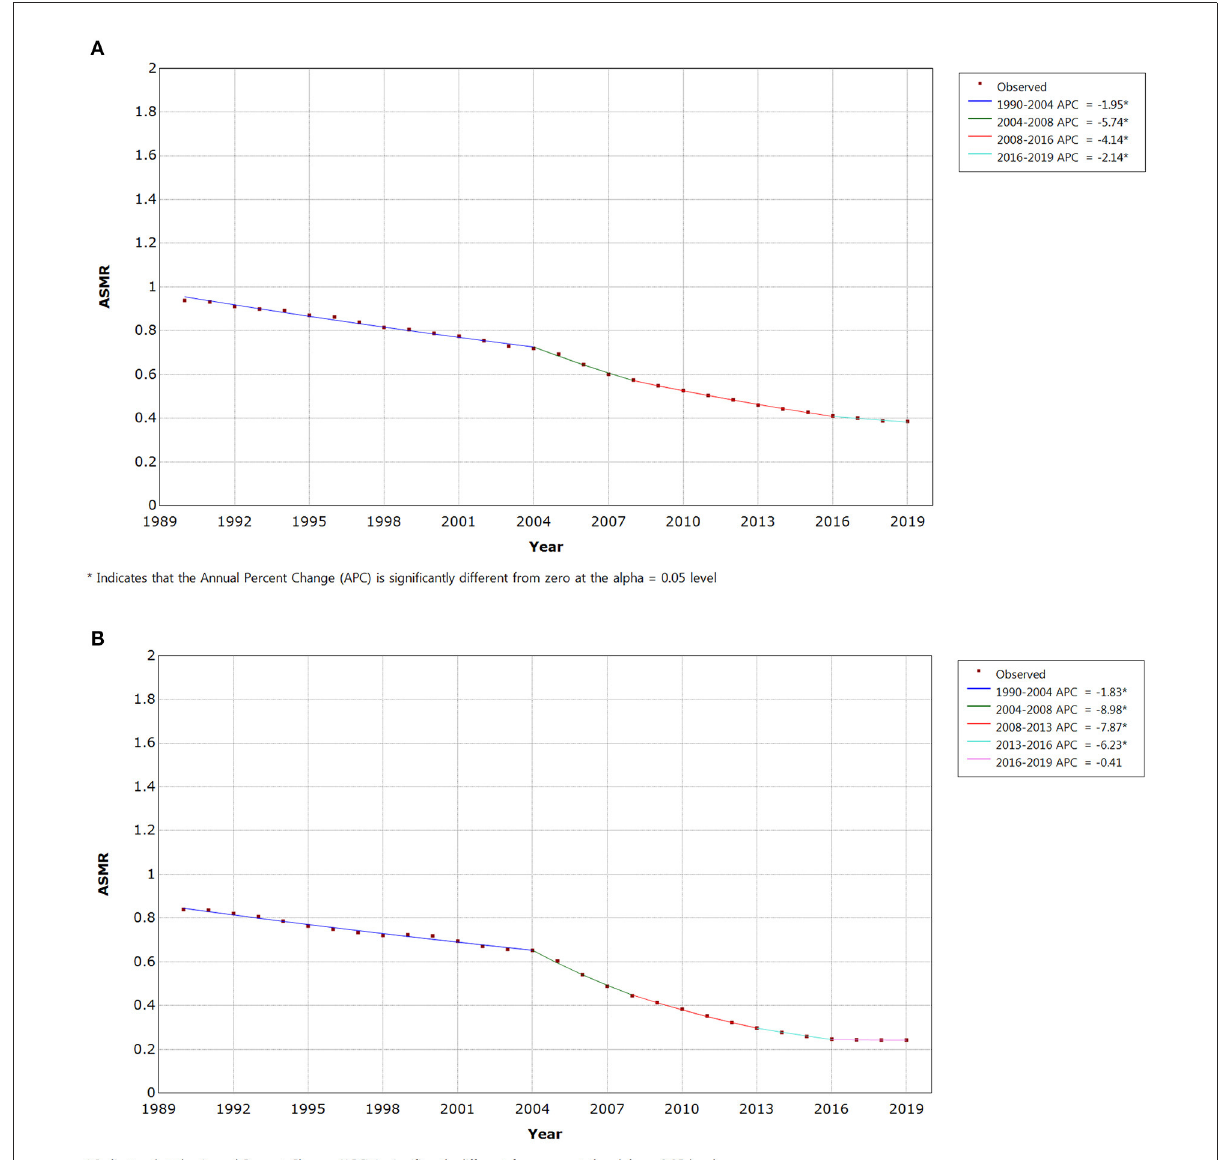
FIGURE4 Joinpoint regression analysis of the sex-specific age-standardized mortality rate for IBD in China from 1990 to 2019. (A) Age-standardized mortality rate for males. (B) Age-standardized mortality rate for females.